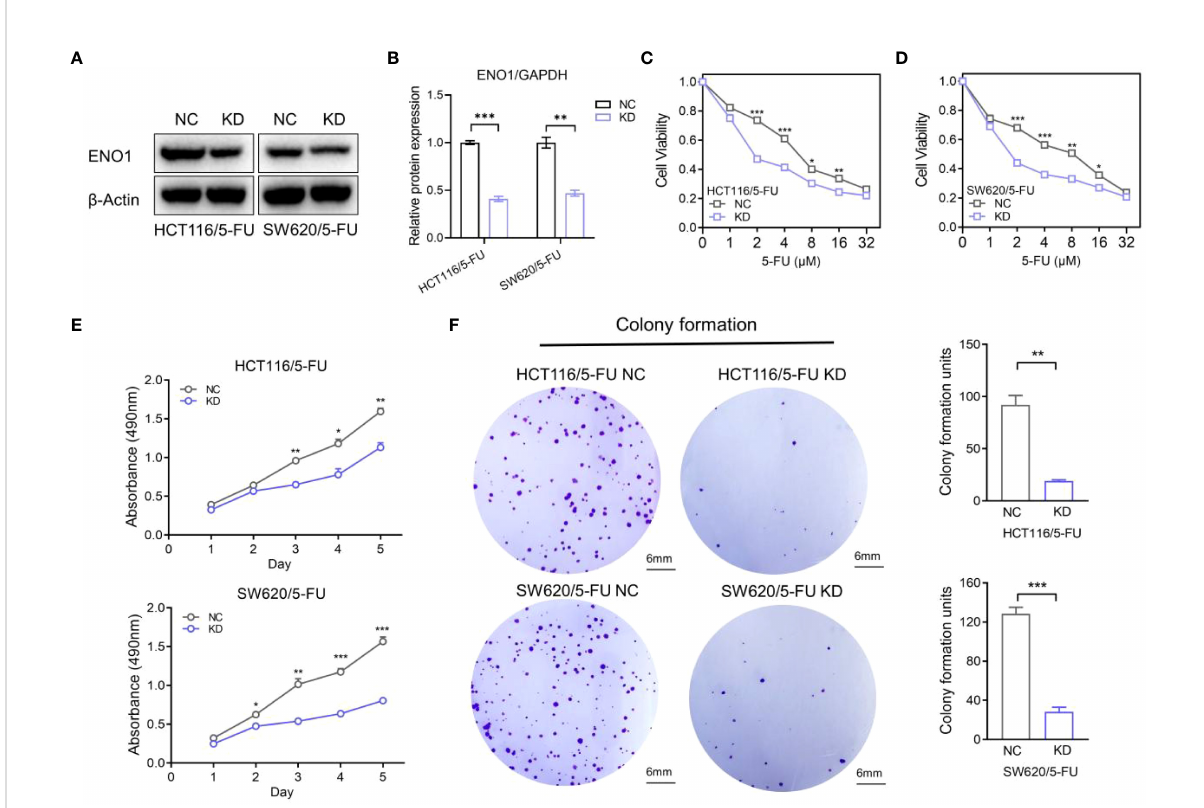
FIGURE 4 Knockdown of ENO1 inhibited the proliferation of 5- fl uorouracil (FU)-resistant colorectal cancer (CRC) cells. (A, B) Immunoblots (A) showing ENO1 protein levels in NC and ENO1-KD group and the quanti fi ed pattern (B) , re fl ecting the success of transfection. (C, D) Cell viability of HCT/ 5-FU (C) and SW620/5-FU (D) cells in the ENO1-KD group and NC group. (E, F) Proliferation rates (E) and colony forming capacity (F) of 5-FU- resistant CRC cells in the ENO1-KD and NC groups (scale bar = 6mm). Statistical analyses were performed via two-tailed Student t test. *,P ≤ 0.05; **,P ≤ 0.01; ***,P ≤